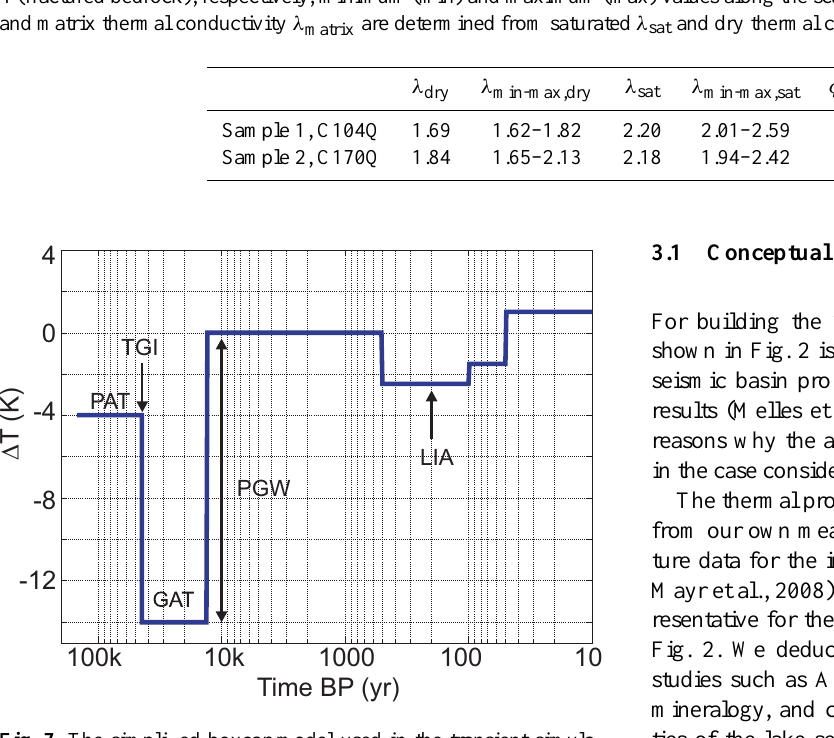
Fig. 7. The simplified boxcar model used in the transient simula- tions. The magnitude of the post-glacial warming (PGW) is influ- encing the gradient of the deeper part of the temperature profile in Fig. 3, whereas the magnitude of the Little Ice Age (LIA) and the recent temperature changes are responsible for the curvature in the shallow domain. The mean ground surface temperature before the LIA is taken as a reference. PAT is the preglacial average temper- ature, TGI is the time of glacial inception, and GAT the average glacial temperature.